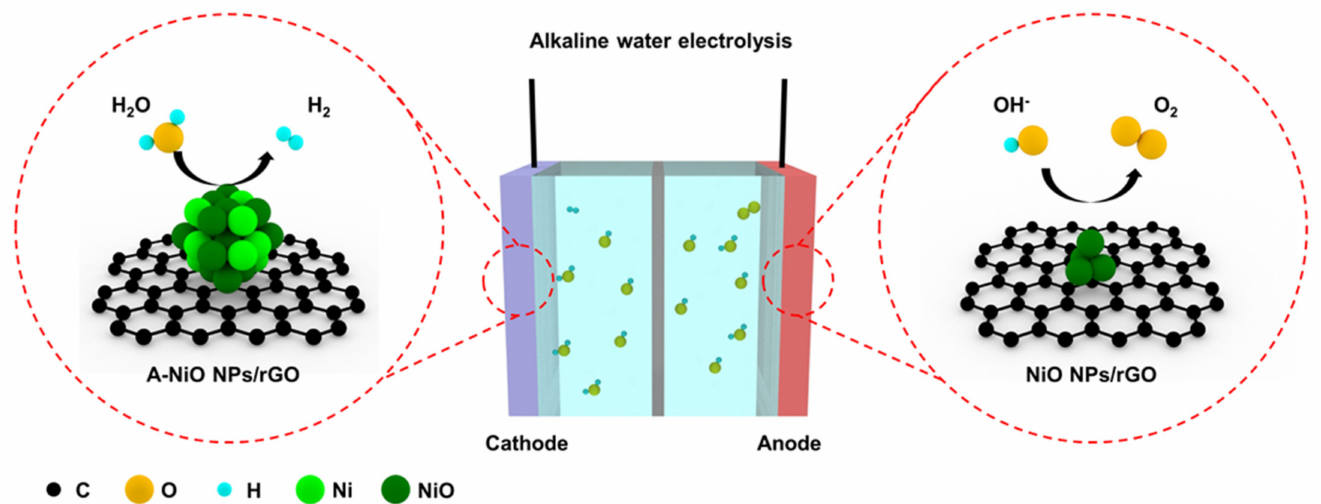
Figure 1. Schematic illustration of the alkaline water electrolysis, where A-NiO NPs/rGO is used for HER and NiO NPs/rGO is applied to OER. Colored spheres indicate several elements (Black: C, Yellow: O, Cyan: H, Light green: Ni, Dark green: